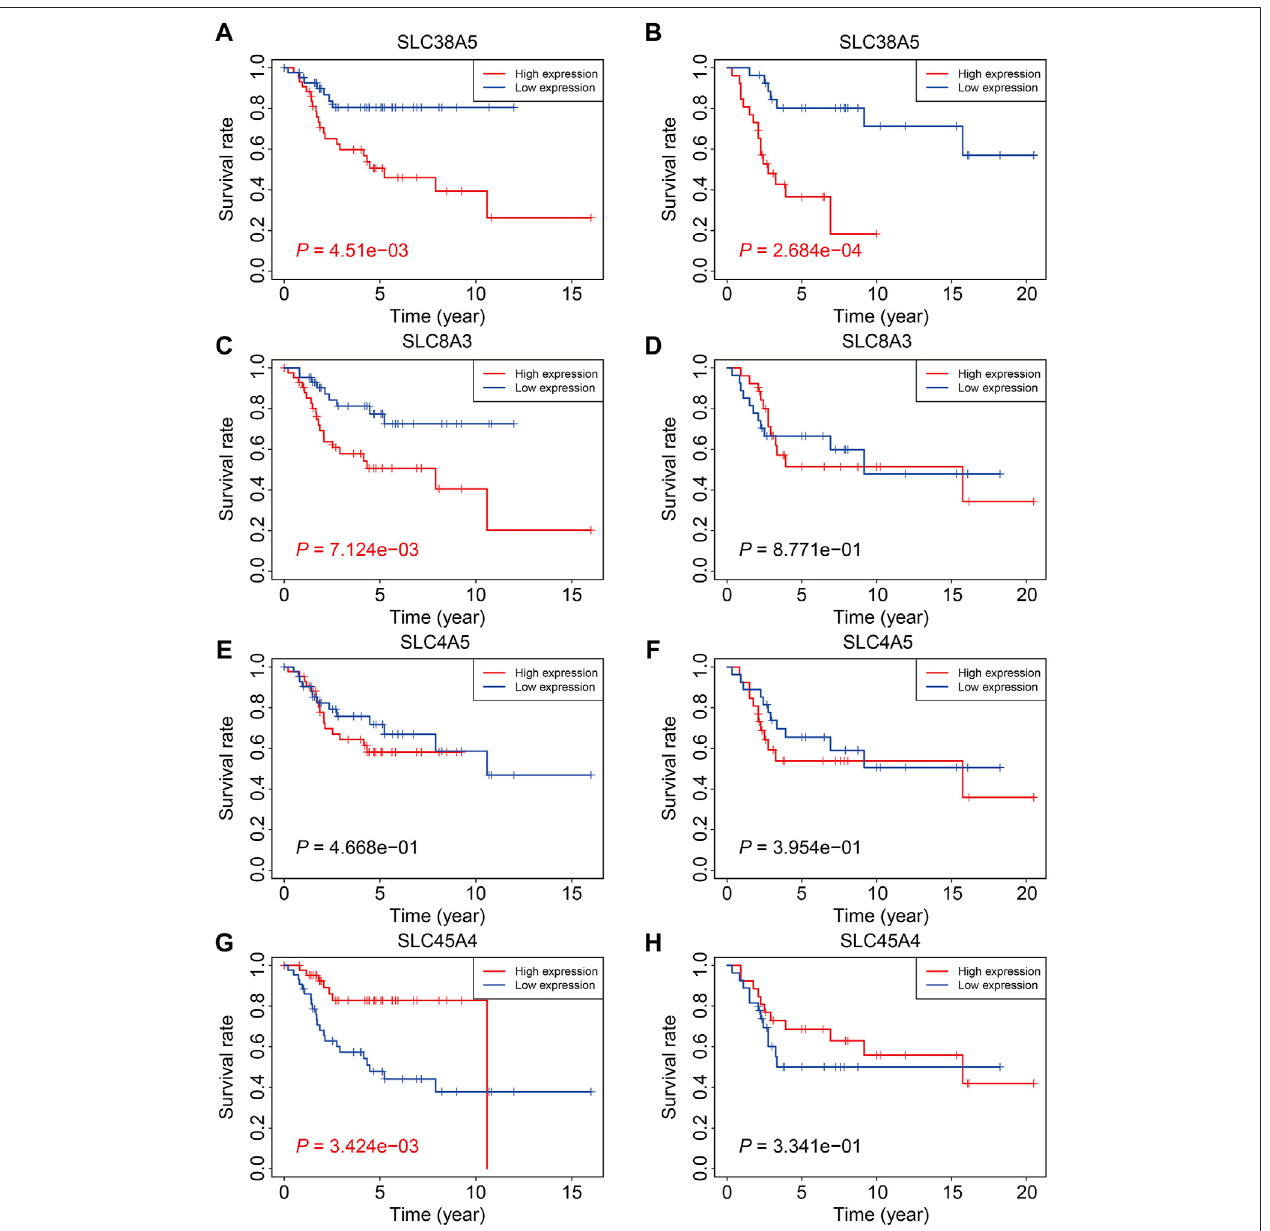
FIGURE 11 | Kaplan-Meier survival analysis of the four SLC genes including SLC38A5 (A,B) , SLC8A3 (C,D) , SLC4A5 (E,F) , and SLC45A4 (G,H) in TCGA osteosarcoma cohort and GSE21257 cohort.